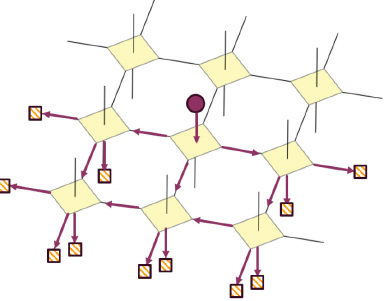
FIG. 11. A tensor network with flat geometry created by con- necting rank-6 perfect tensors (yellow). This creates a code where each logical degree of freedom is localized to the “bulk” legs pointing up. The physical representation and support of a logical operator can be found via pushing just like the holo- graphic